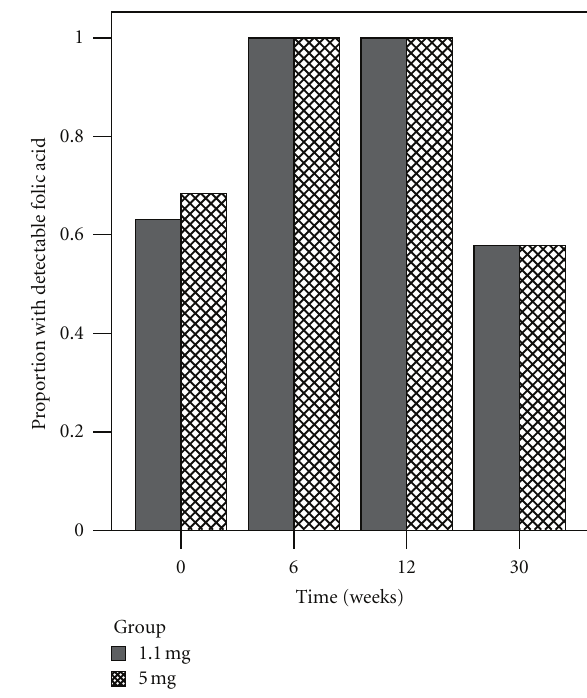
Figure 7: Proportion of plasma samples with detectable concen- trations of unmetabolized folic acid. Detection rates at week 6 and week 12 were significantly higher compared to baseline (week 0) in both the 1.1 mg (#) and 5 mg ( § )